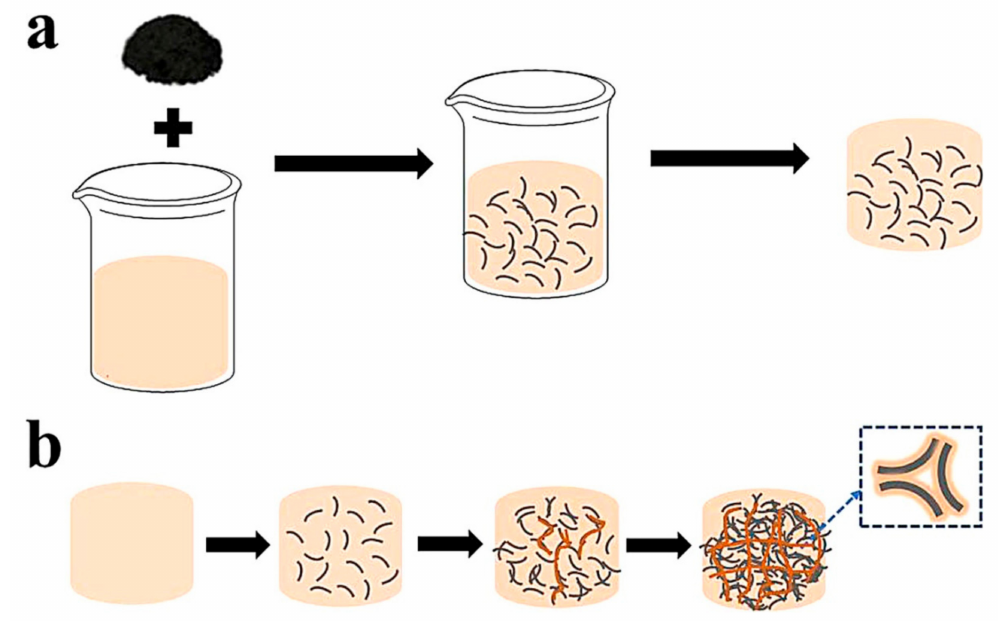
Figure 3. Schematic process of blending method for preparation of polymer composites. ( a ) The general concept for polymer composites preparation by using solution blending method. ( b ) Uniform dispersion of different filler contents in the polymer matrix. Reprinted with permission from [47]. Copyright 2020 Elsevier